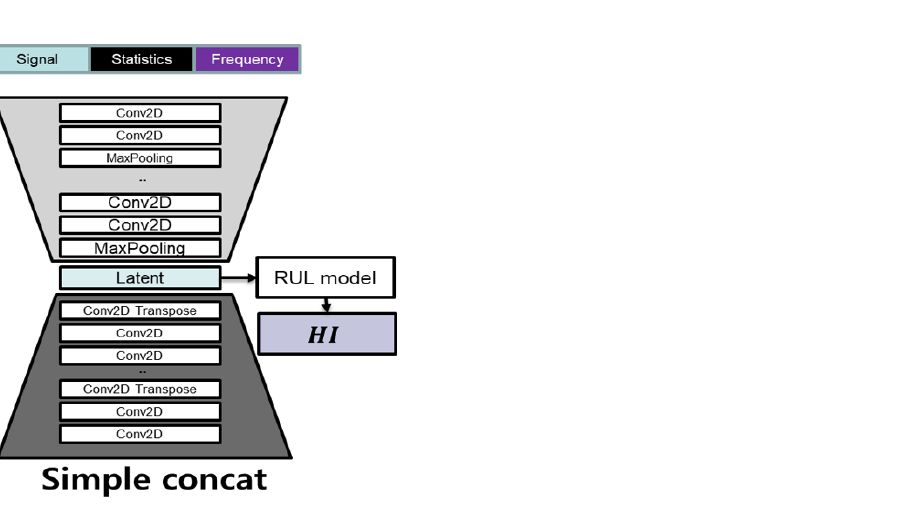
Figure 11. Network models of simple concatenate.